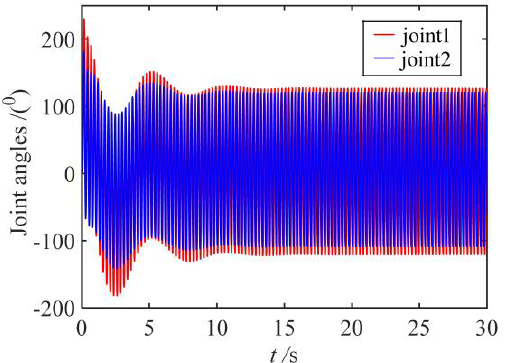
Figure 6. 2st joint motor output torque.